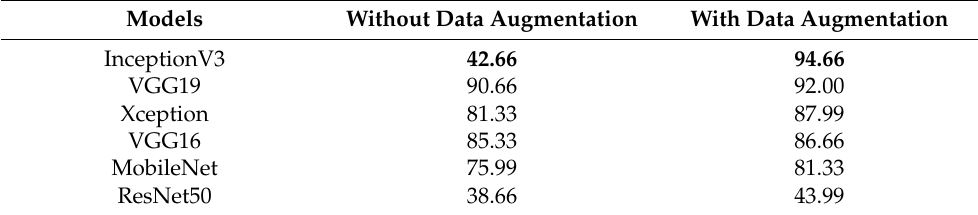
Table 3. Accuracy of pre-trained CNN based transfer-learning